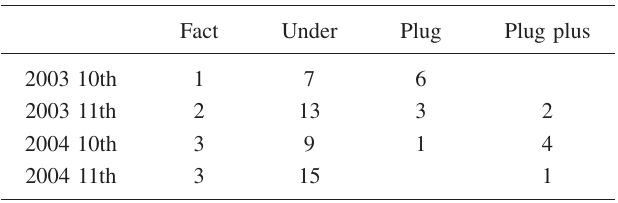
TABLE VII. Numbers of physics and physical science items with each knowledge or skills code by year and grade